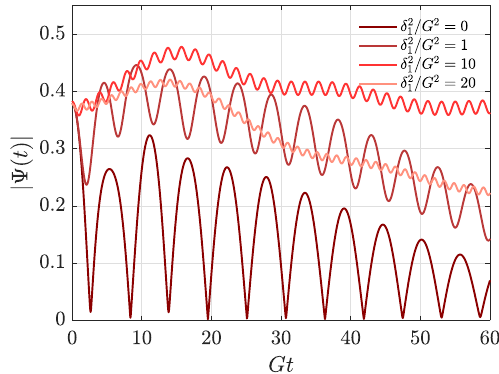
FIG. 4. Realizing the two-channel model. The drumhead c.m. mode plays the role of the molecular channel in the two-channel p -wave model. As the coupling to the c.m. mode is tuned from off / G 2 (cid:11) 1) to near resonance ( δ 2 / G 2 ∼ 0), its effects resonant ( δ 2 1 1 can be clearly observed in the time evolution of | (cid:5)( t ) | . Here, √ 10 and vary δ 1 to obtain the different curves. we fix B 1 = G / Crystal parameters are detailed in Appendix B and chiral spin states are initialized according to Appendix